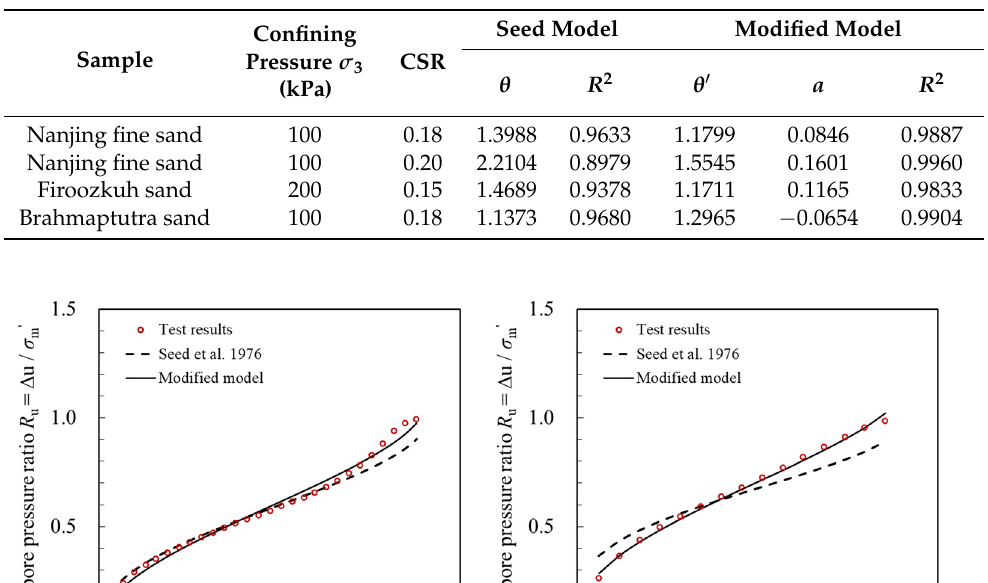
Table 9. Fitting parameters and effect of models based on the past test data.